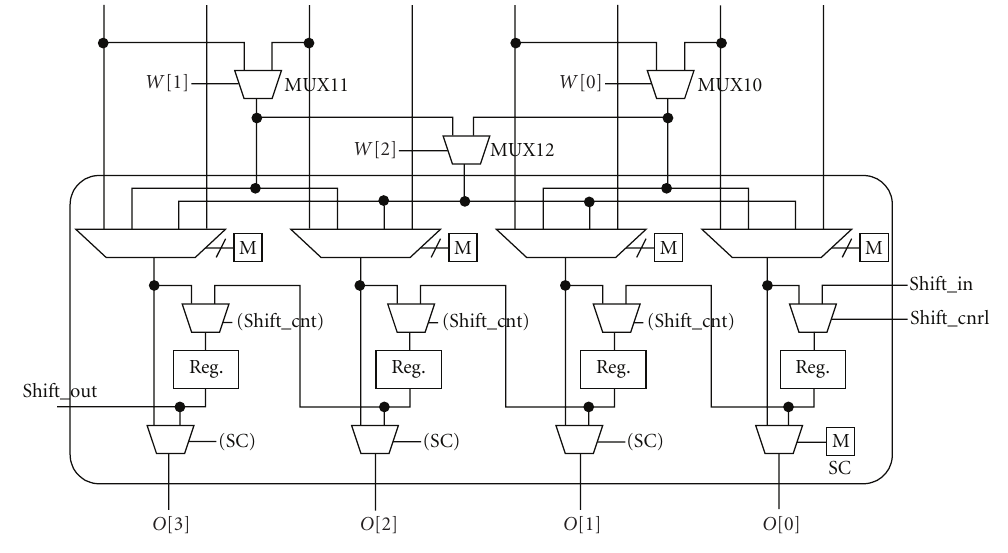
Figure 7: Output selector